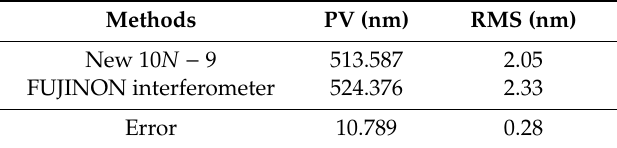
Table 2. The comparison of di ff erent methods.